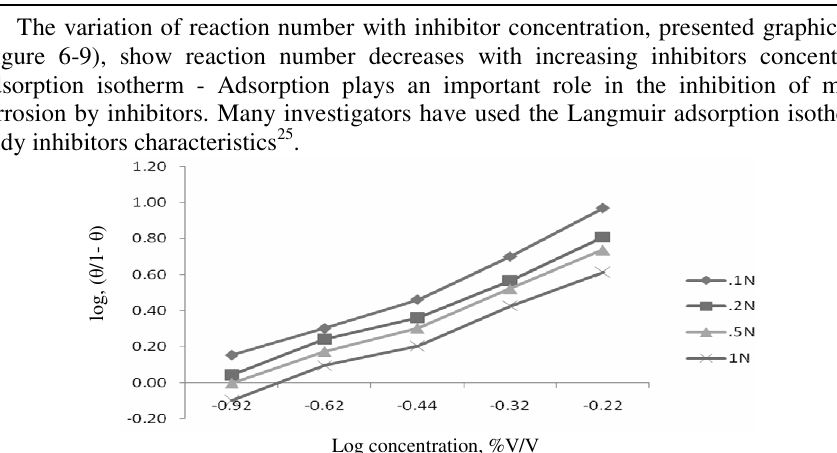
Figure 5. Langmuir adsorption isotherm of leaves extract for mild steel in hydrochloric acid with inhibitor concentration